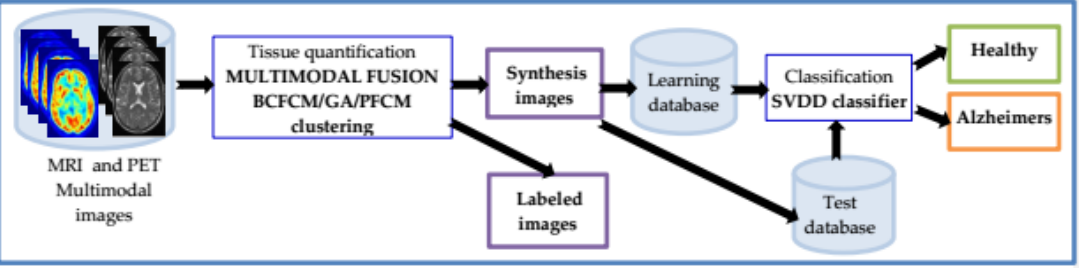
Figure 1. Overall block diagram of the proposed multimodal CAD system for early diagnosis of AD. Based on hybrid fuzzy-possibilistic-genetic tissue quantification and SVDD classifier.